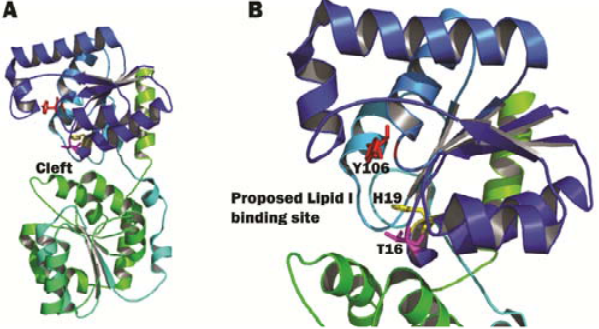
Figure 9. E. coli MurG structure. ( A ) The complete view of E. coli MurG, N-domain in blue, C-domain in green. The cleft in between the two domains is indicated by an arrow; ( B ) A close-up view of the cleft between the N- and C-domains of MurG. Residues T16 (pink), H19 (yellow) and Y106 (red) are shown as sticks. The proposed Lipid I binding site is indicated by an arrow. The image was obtained and rendered using Pymol.